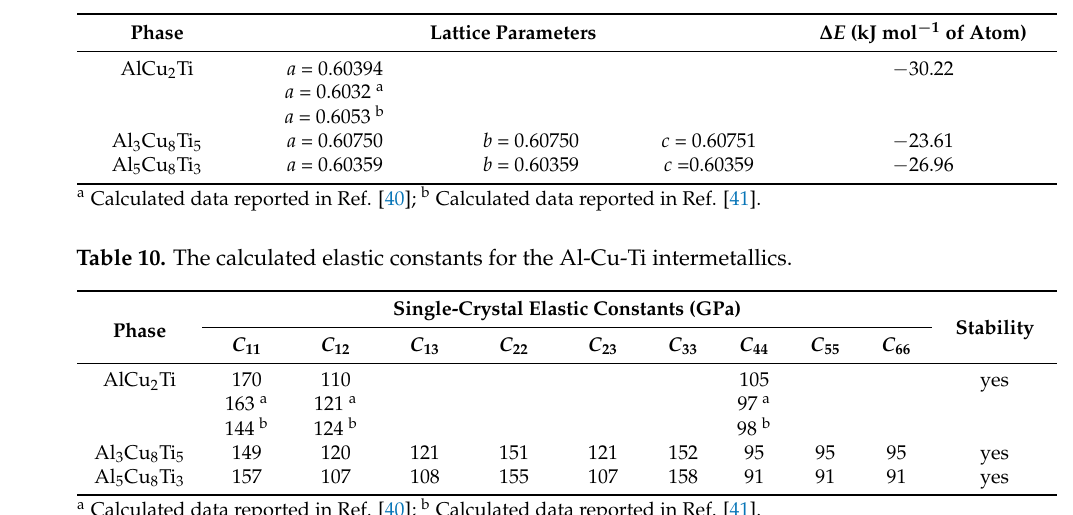
Figure 11. The crystal structures of AlCu 2 Ti, Al 3 Cu 8 Ti 5 , and Al 5 Cu 8 Ti 3 , with the pink balls, the blue balls and the yellow balls representing Cu, Ti, and Al, respectively. Table 9. The calculated lattice parameters ( a , b , and c in nm) for the Al-Cu-Ti intermetallics, compared with the other theoretical results.